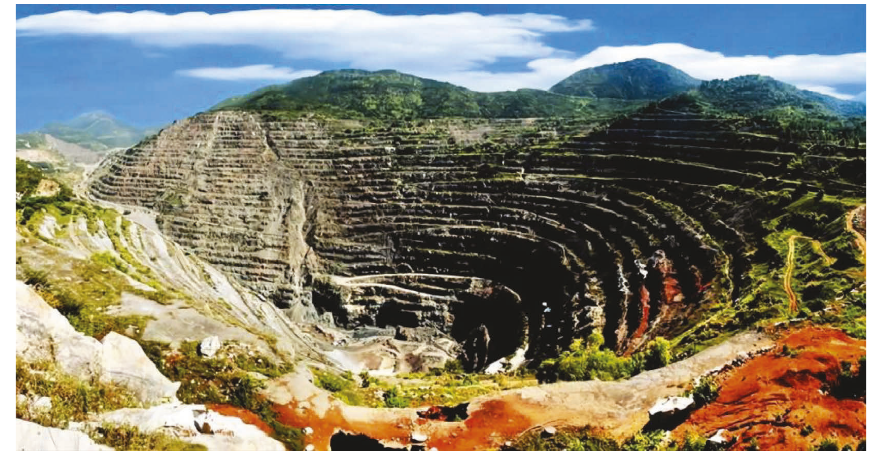
Figure 4: Bird’s eye view of the east open pit.